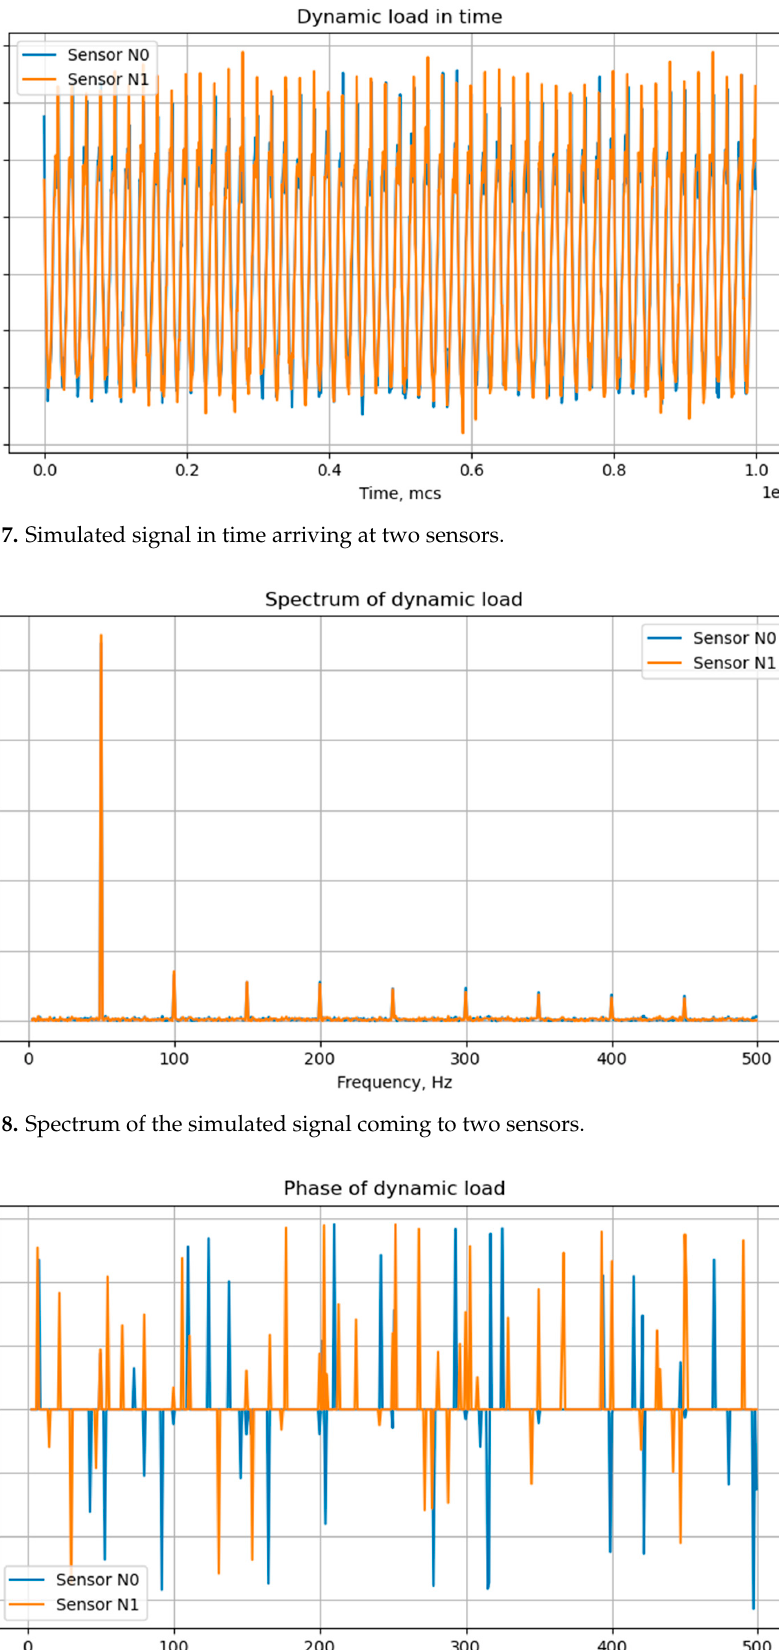
Figure 9. Phase spectrum of the simulated signal arriving at two sensors.